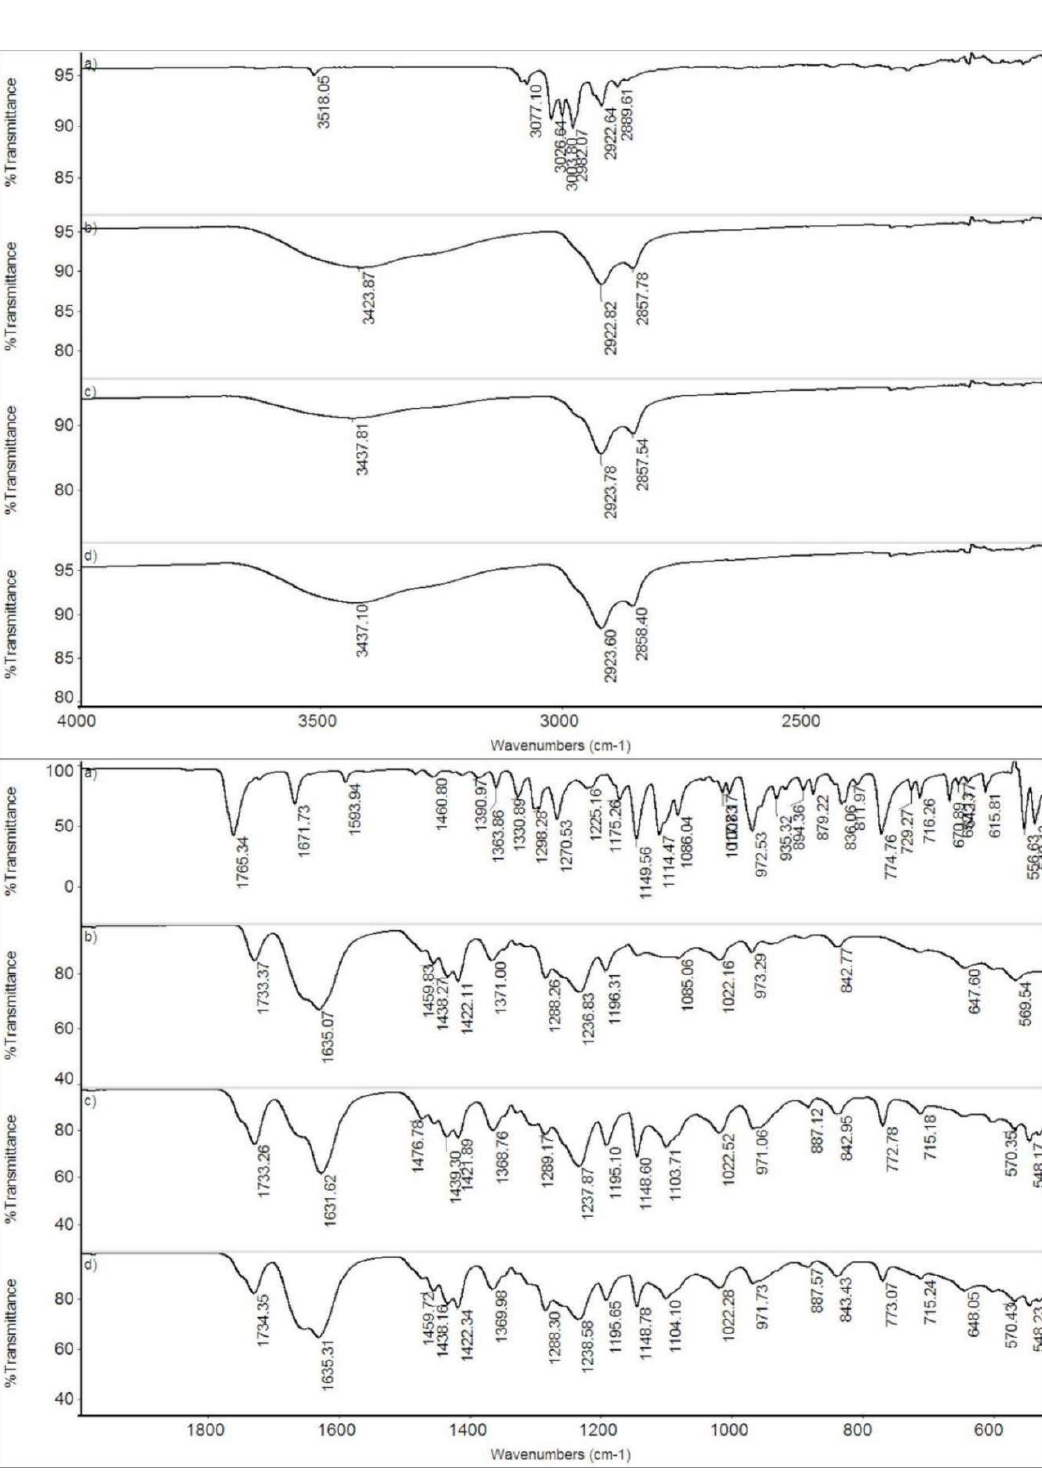
Figure 6. FT-IR spectra of firocoxib ( a ), PVP:SOL (1:1) ( b ), F:PVP:SOL (1:2:2) ( c ), and F:PVP:SOL (1:4:4) ( d ).